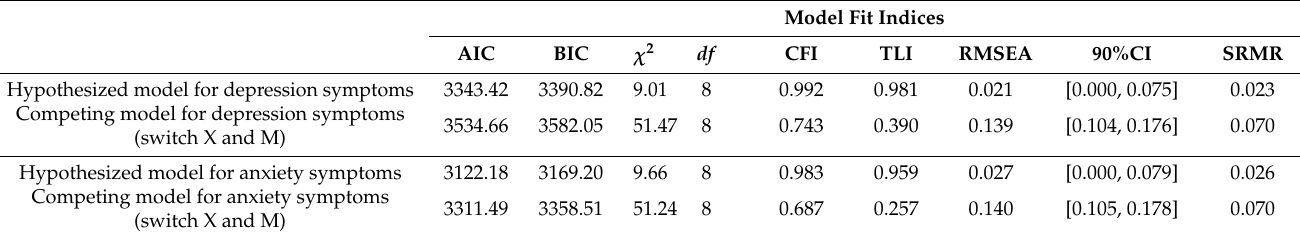
Table 5. Summary of the model fit indices of the competing